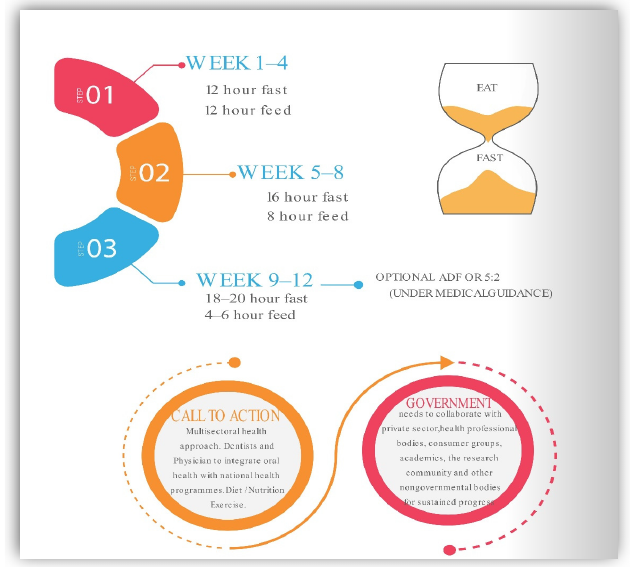
Figure 6. Suggested integrated approach to practice IF as a preventive interventional strategy.